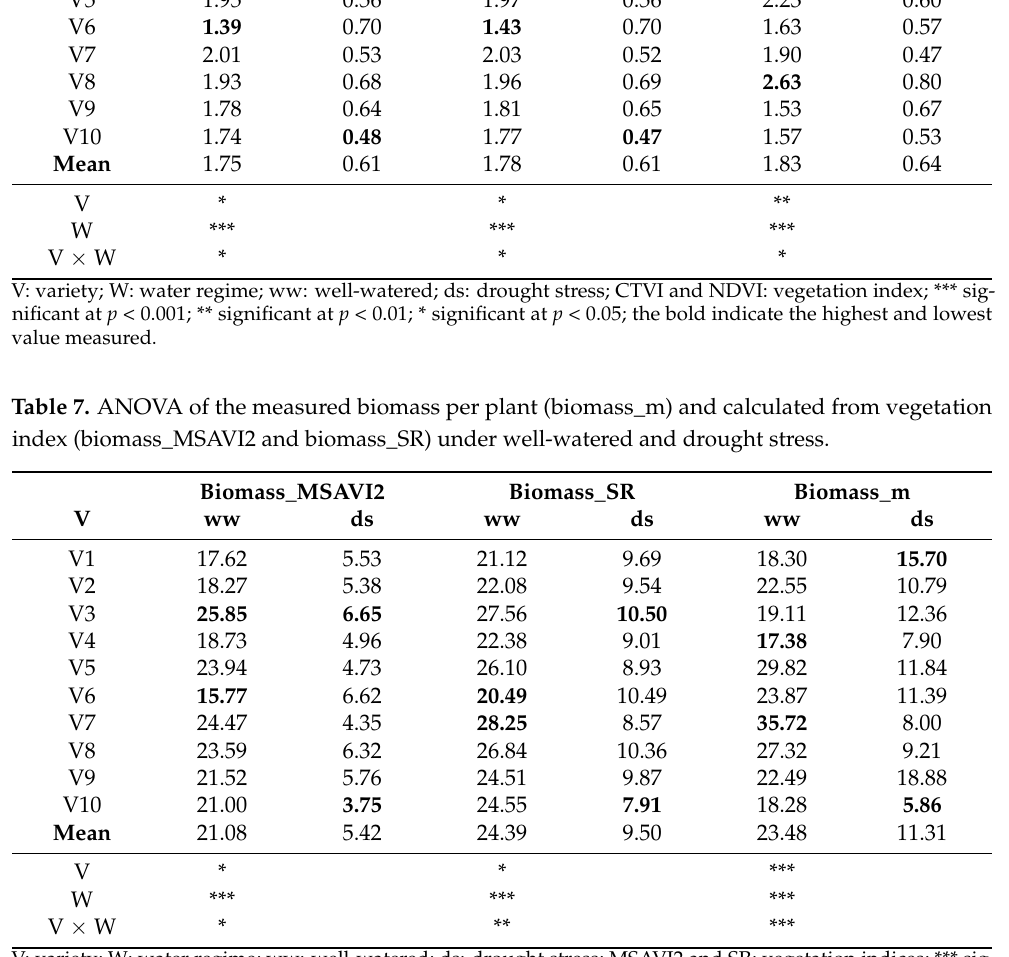
Table 6. ANOVA of leaf area index measured (LAIm) and calculated from vegetation index (LAI_NDVI and LAI_CTVI) of varieties under well-watered and drought stress. LAI_NDVI LAI_CTVI LAI_m V ww ds